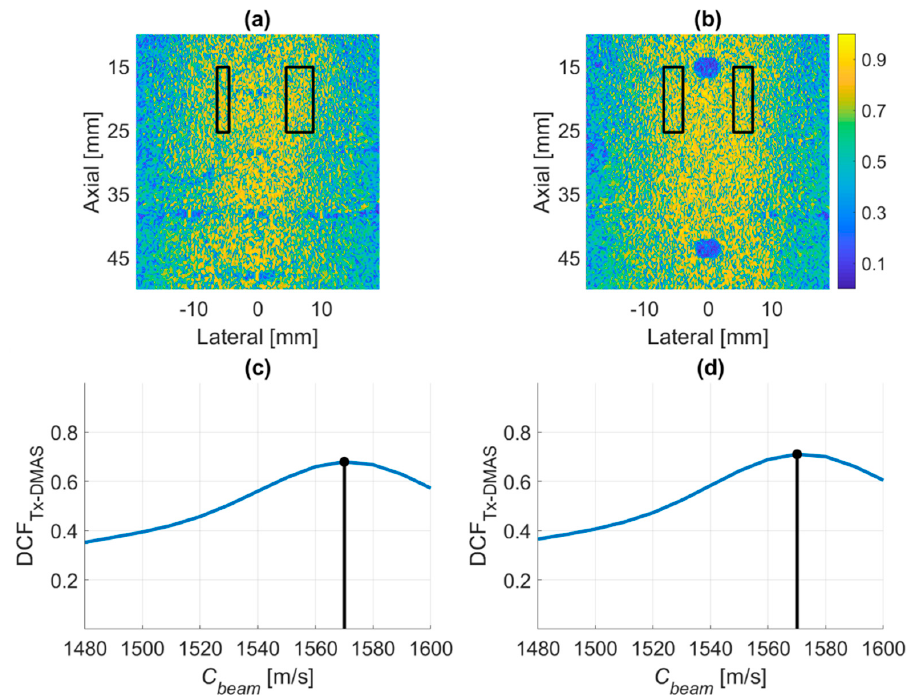
Figure 8. ( a , b ) DCF map of Tx-DMAS beamforming for two different FOVs of PICMUS experimental phantom. ( c , d ) Respective plot of averaged DCF value in ( a , b ) as a function of C beam .